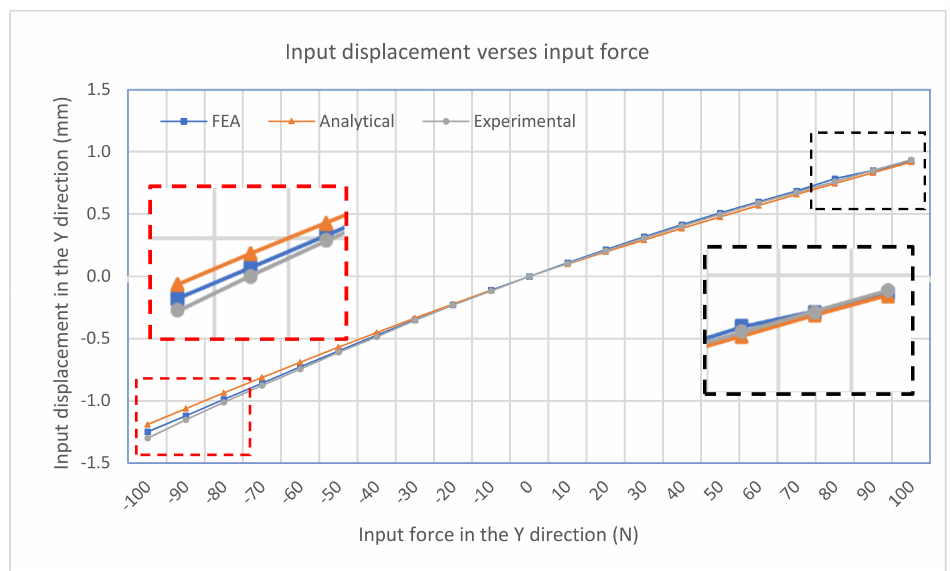
Figure 10. Input-force and output-displacement relationship.